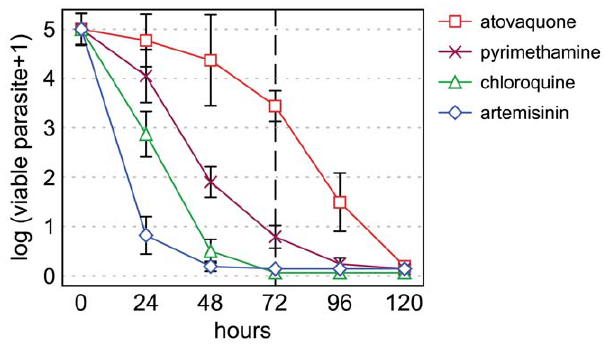
Figure 5. Classical antimalarial killing rate profiles. P. falciparum viability time-course profiles of four classical antimalarial drugs, illustrating the wide range of speed-of-action measured. Viable parasite are cleared in response to fast-acting (art and chq), but not slow-acting (pyri and ato) drugs after 72 hours of treatment.